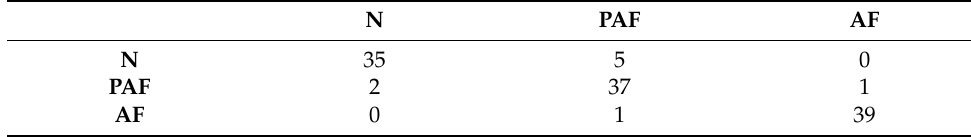
Table 8. Classification results of the fusion model in the FZU-FPH test